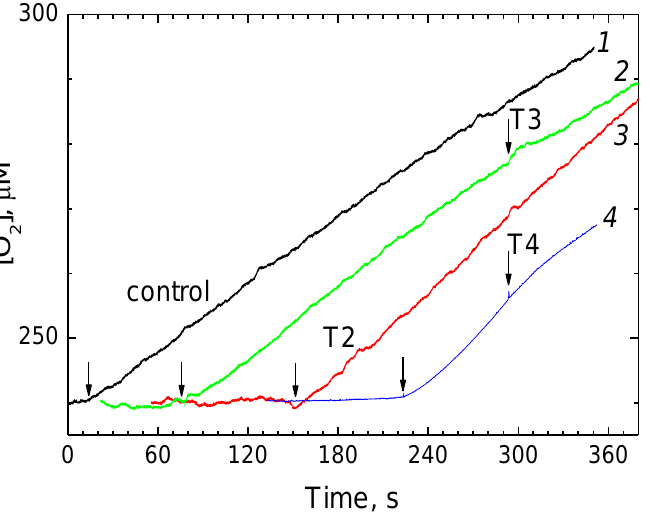
Figure 5. Thyroid hormones do not inhibit catalase activity of CcO. Pre-addition of 12 mM H 2 O 2 to the experimental medium did not induce detectable oxygen release. Additions of 1.5 µ M CcO are indicated by the vertical arrows. Trace 1 , black = control; traces 2 – 4 = thyroid hormones (T3 = 2 , green; T2 = 3 , red; T4 = 4 , blue). T2 was pre-added up to 0.5 mM; T3 and T4 were added up to 0.5 mM and 1 mM, respectively, as marked.